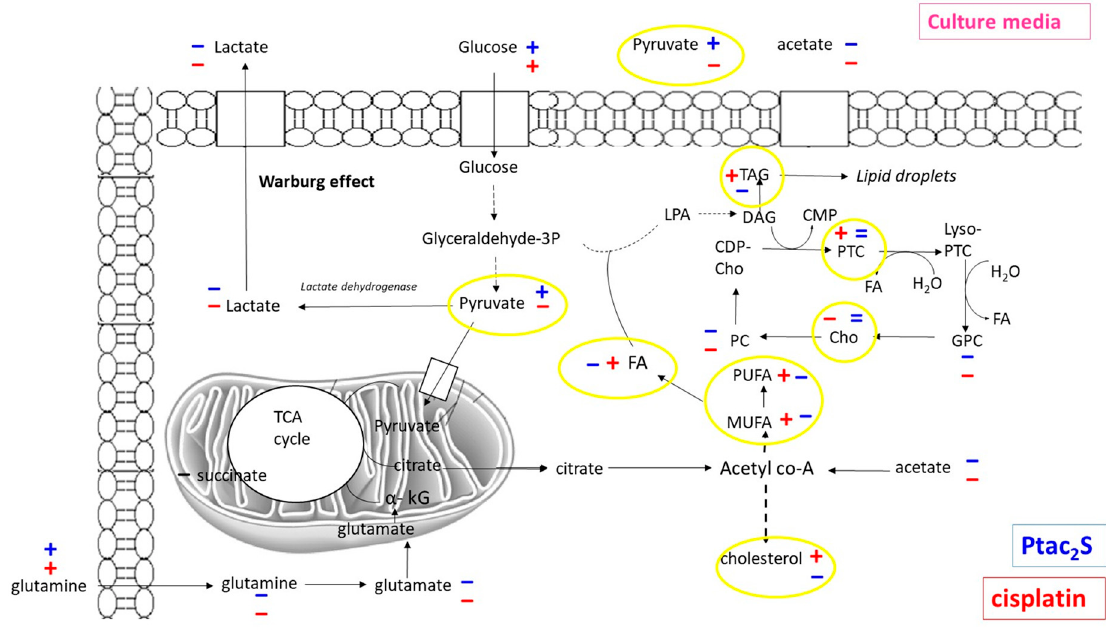
Figure 12. Schematic representation of main metabolic pathways altered at 24 h after Ptac2S (blue) and cisplatin (red) treatment of SKOV-3 cells. Comparison with the 24 h of the controls. Positive (+) and negative ( − ) signs indicate positive and negative correlations in the concentration, respectively.